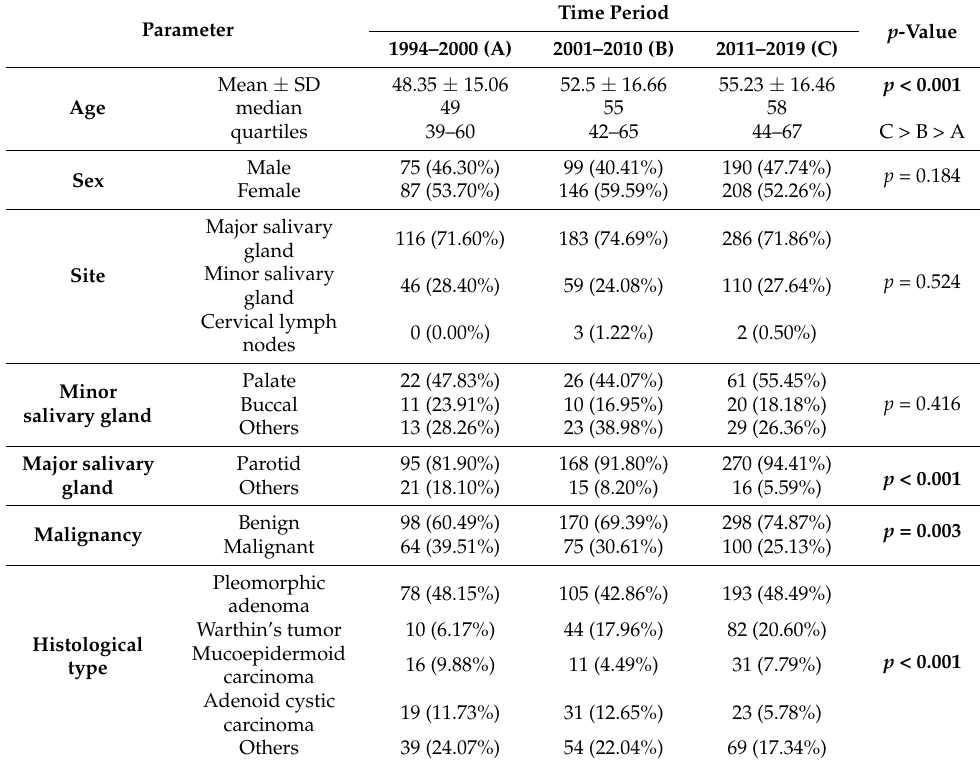
Table 5. Clinicopathological characteristics by time